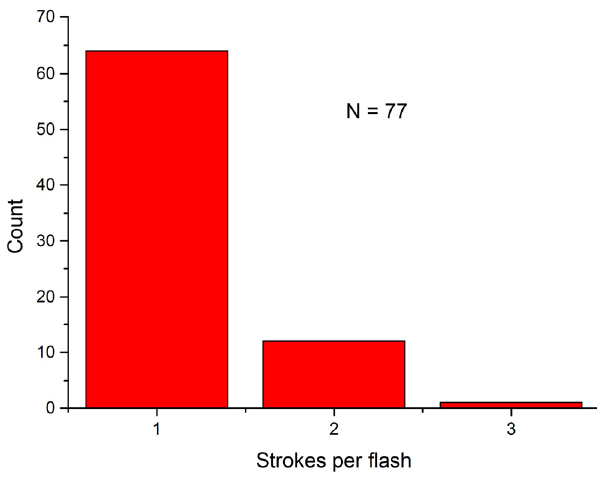
Figure 3. Distribution of strokes per flash.